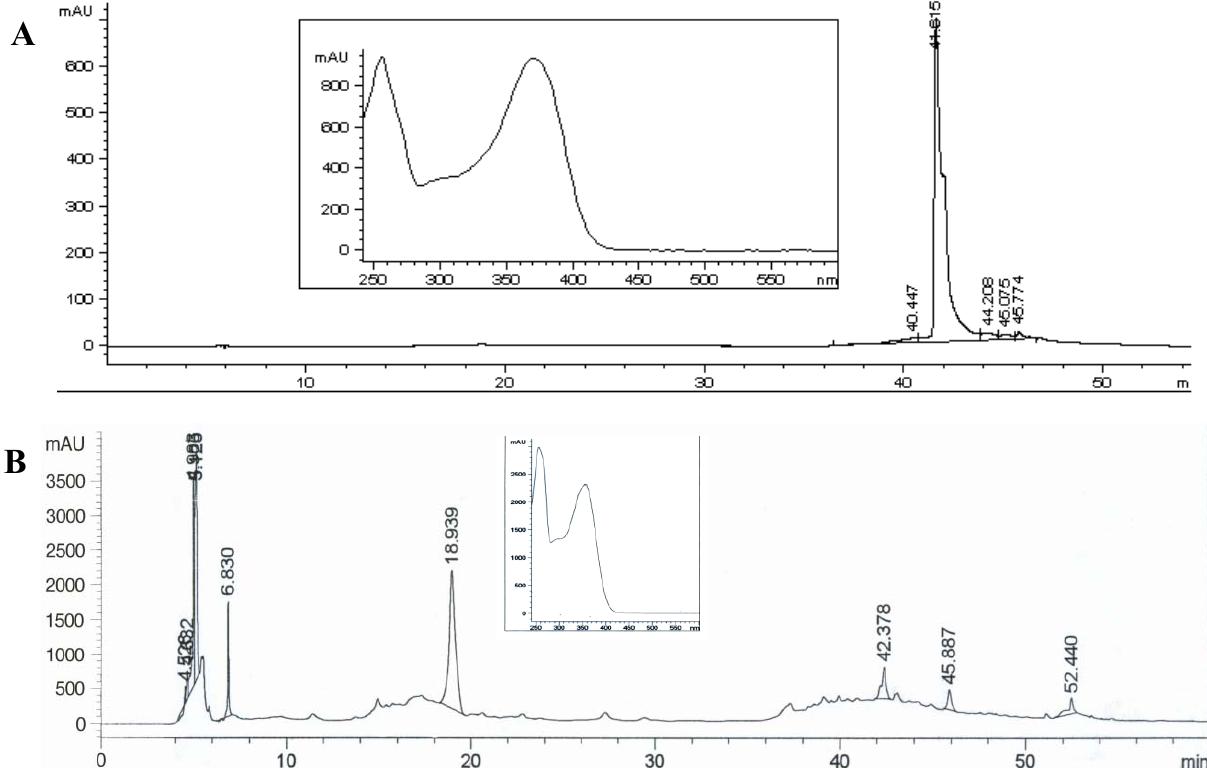
Figure 2. HPLC-DAD chromatograms and respective UV spectrum of compounds 2 ( A ; R = 18.939 min) and 3 ( B ; R = 41.615 min). Zorbax SB C column (250 × 4.6 mm, t t 18 5 mm). Solvent gradient: 0–5 min 12% de acetonitrile (B) in acetic acid 0.1% (A); 5–8 min 12–20% B in A; 8–28 min 20% B in A; 28–38 min 20–50% B in A; 38–48 min 50–65%